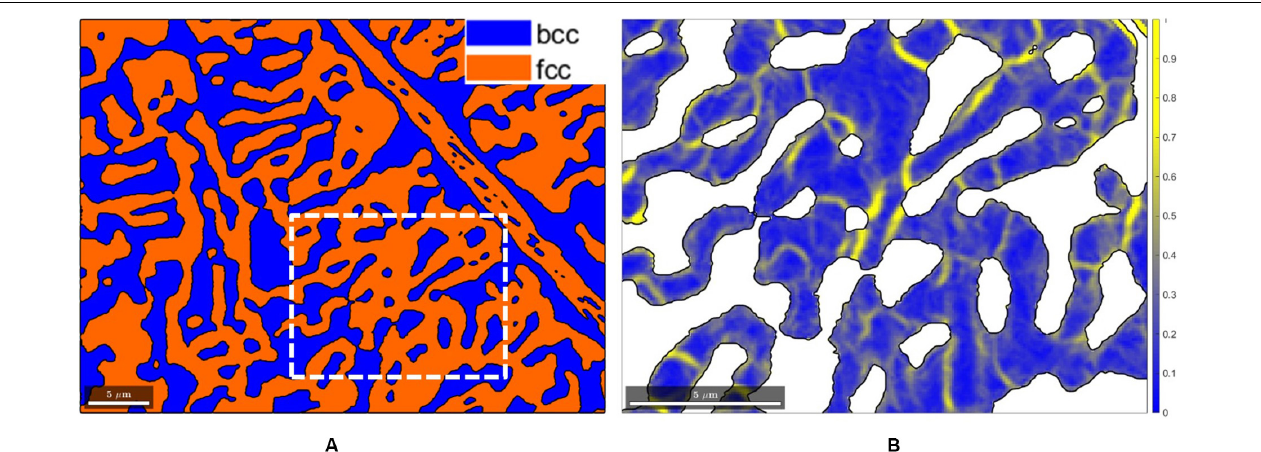
Frontiers in Materials |